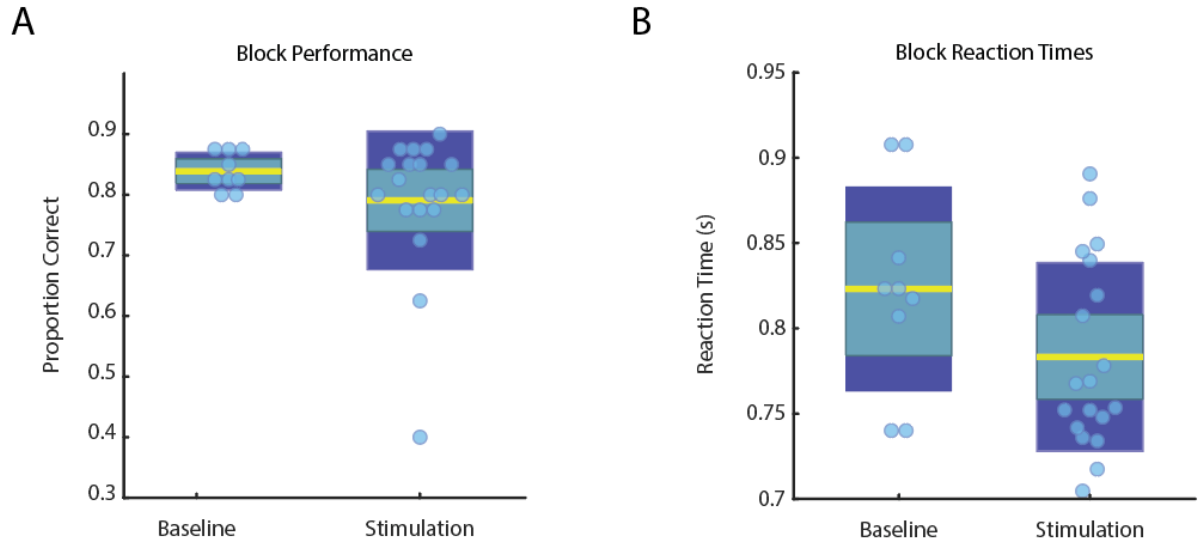
Figure 4. Performance ( A ) and reaction time ( B ) on the 2-back was comparable for baseline ( n = 9) and dlPFC stimulation ( n = 19) blocks, suggesting stimulation did not significantly impair cognitive function. Data for each block are indicated by the light-blue circles, standard deviation in dark-blue, standard error in teal, and the mean in